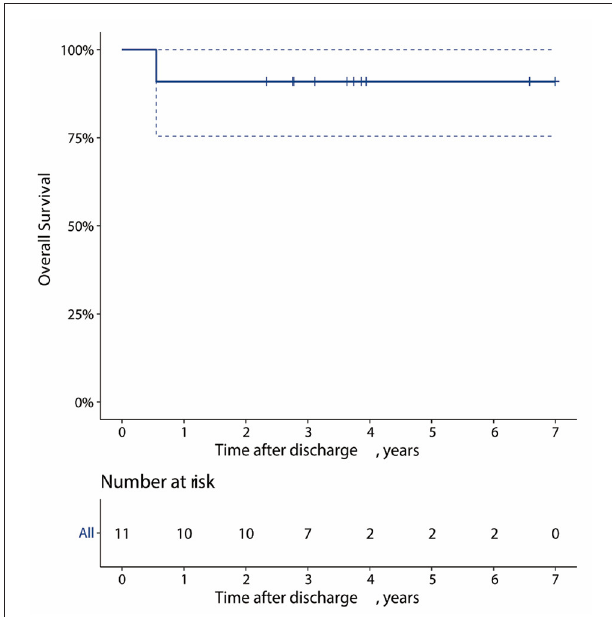
FIGURE 5 | Kaplan–Meier curve of 7-year survival from all-cause mortality in the patients.